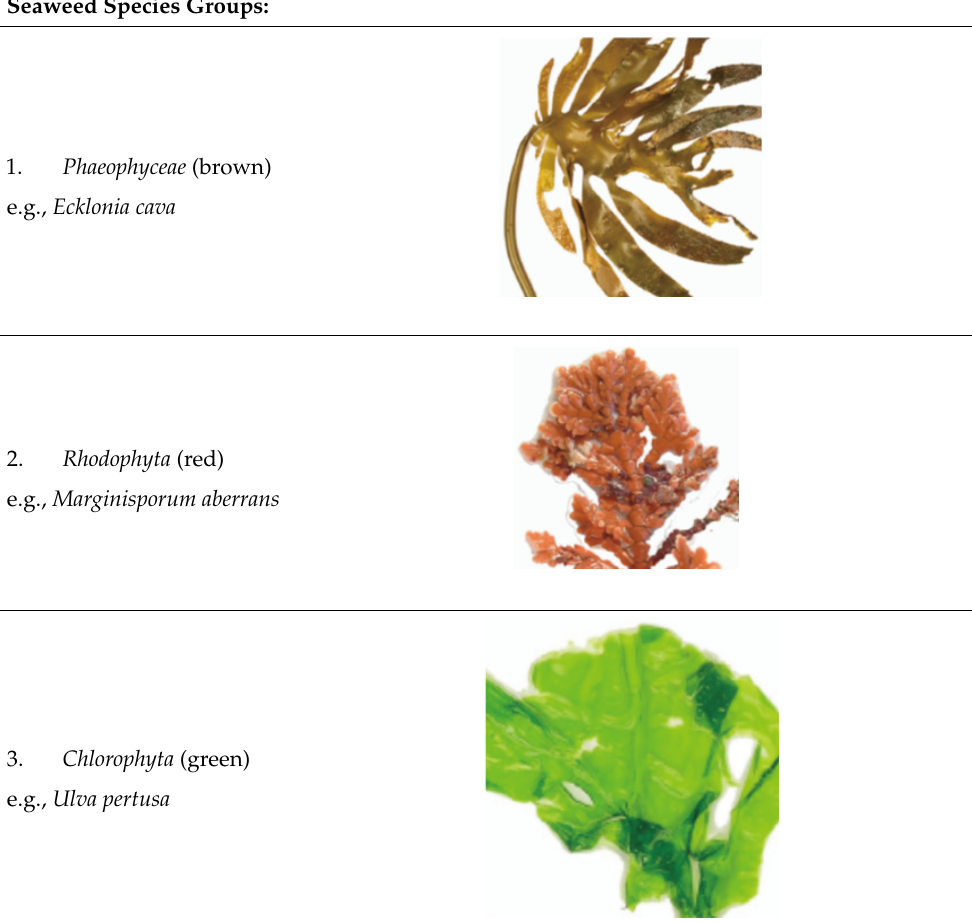
Table 1. Visual comparison of the colour of the three main groups of seaweed species adapated from [9,20]. Seaweed Species